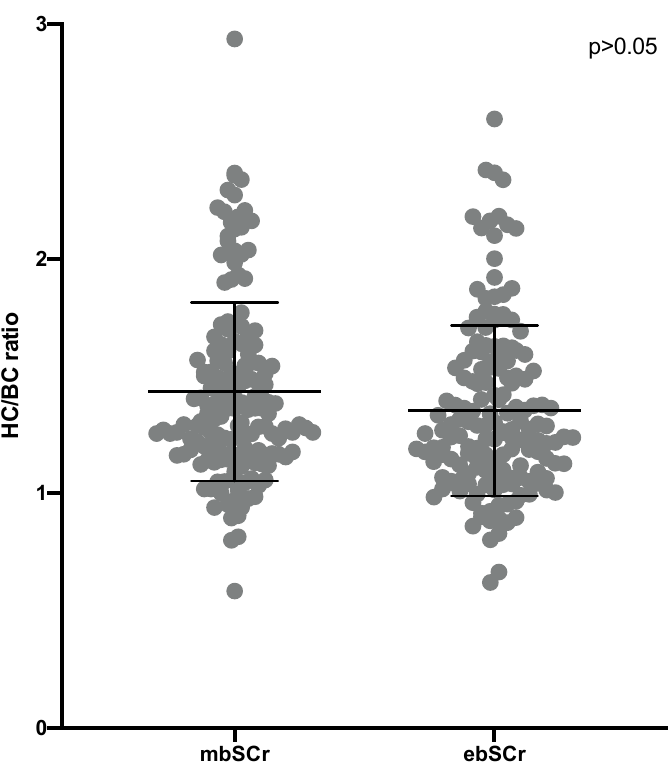
Figure 1. Highest/baseline creatinine (HC/BC) ratio calculated on the basis of the measured baseline creatinine (mbSCr) compared with the HC/BC ratio calculated on the basis of height-estimated baseline creatinine (ebSCr). Figure 1 legend: Means ± SDS are shown. However, these variables being non-normally distributed, they were compared by the Mann–Whitney test. ebSCr showed good correlation with mbSCr both in the Spearman test (rho= 0.67; p < 0.001) and regression analysis (Figure 2).